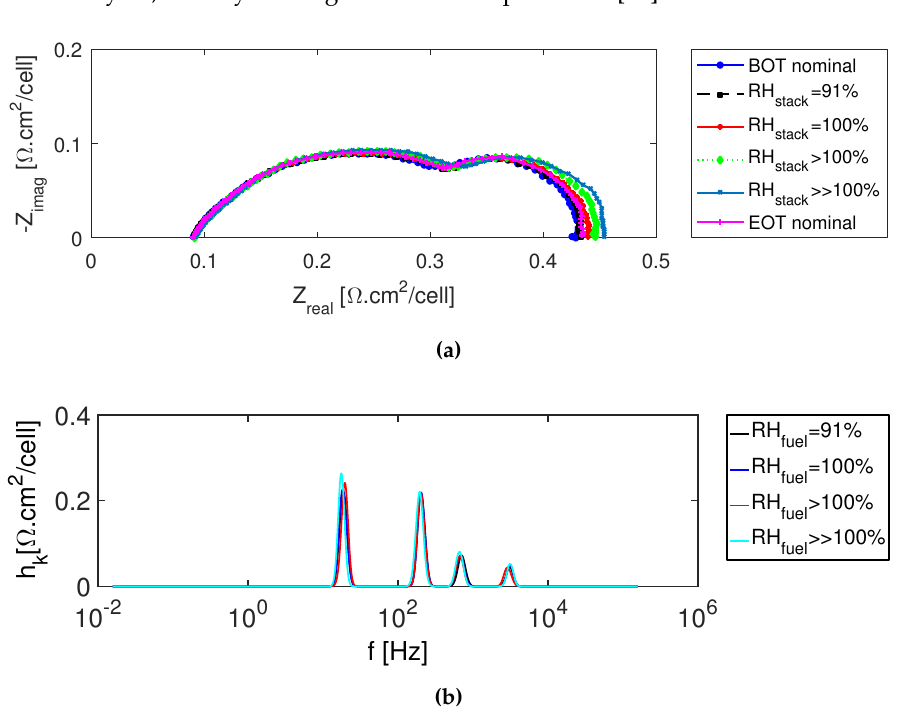
Figure 4. Flooding tests on both the anode and cathode simultaneously at 40 A: ( a ) EIS spectra; ( b ) DRT